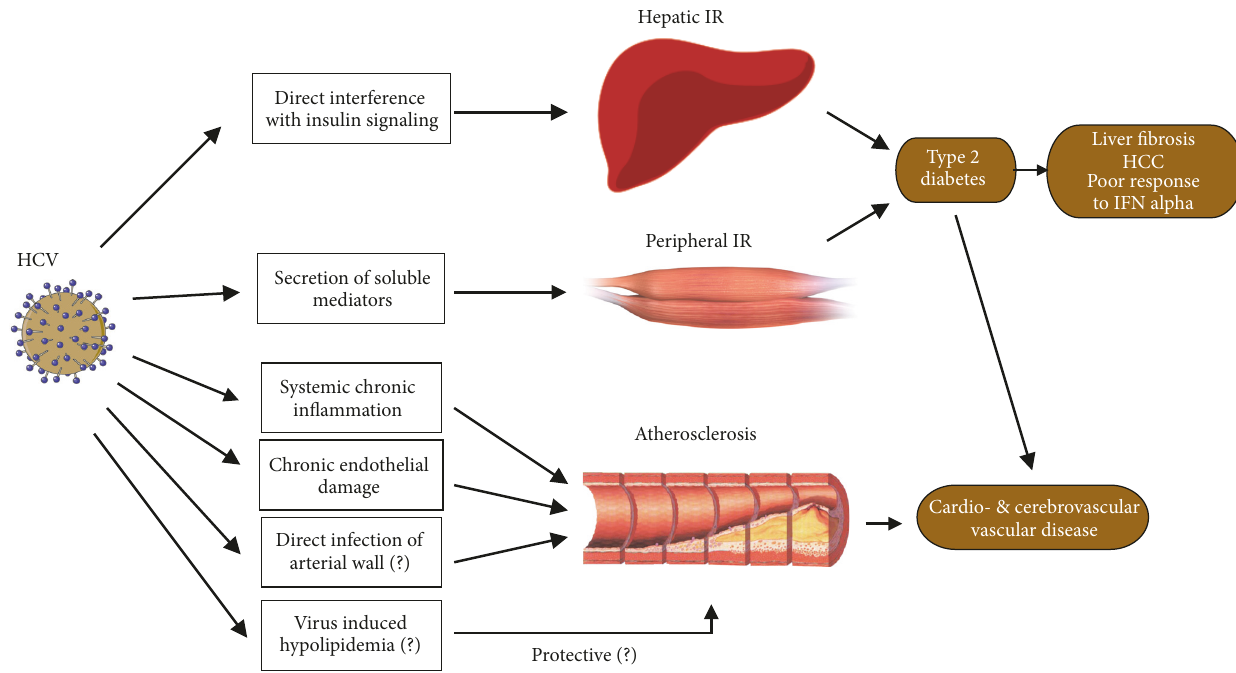
Figure 1: Schematic representation of interactions between hepatitis C virus and cardiovascular risk. Adapted from Negro 2014